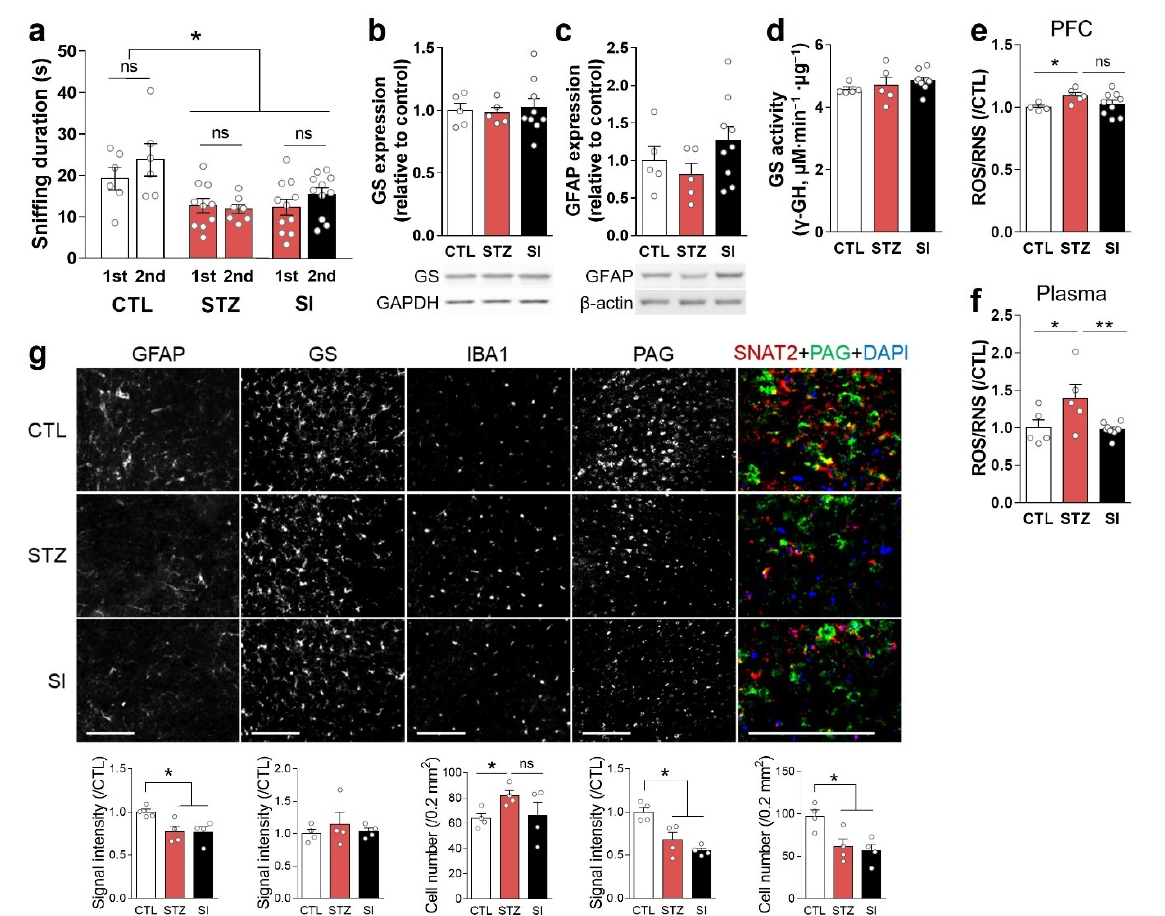
Figure 7. Insulin treatment could not completely reverse hyperglycemia-induced behavioral and alterations in the PFC. ( a ) Sniffing time in female urine sniffing tests conducted 3 weeks after STZ injection (1st) and 3 weeks after insulin implantation (2nd). CTL, n = 7; STZ, n = 7; SI, n = 11. ( b , c ) Representative images and quantification in Western blots of GS ( b ) and GFAP ( c ) using PFC crude lysates. ( d ) GS activity analysis using PFC crude lysates. ( e , f ) Reactive oxygen/nitrogen species (ROS/RNS) in the PFC ( e ) and plasma ( f ). ( b – f ) CTL, n = 5; STZ, n = 5; SI, n = 9. ( g ) Immunohistochemical analysis of GFAP, GS, IBA1, phosphate-activated glutaminase (PAG), and sodium-dependent neutral amino acid transporter 2 (SNAT2) in the infralimbic mPFC. The upper panel shows representative images, and the lower panel shows quantifications. n = 4/group. Scale bar = 100 µ m. Data are presented as mean ± SEM. * p < 0.05, ** p < 0.01 between indicated groups according to one-way ANOVA